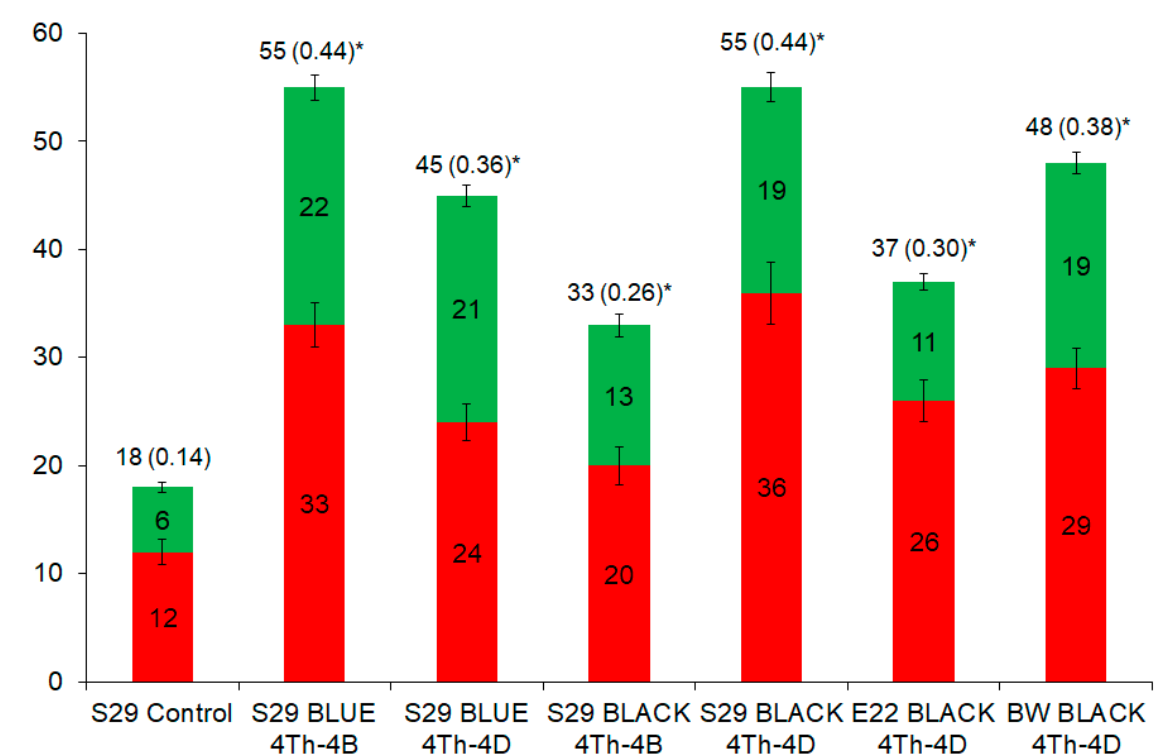
Figure 3. The number of the phenolic (red) and non-phenolic (green) compounds that were detected in the differently colored grains of the seven wheat lines. Error bars denote standard deviation; the number of individual compounds and its proportion among all the annotated compounds (125) are shown above the bars. * A significant difference from the control line.